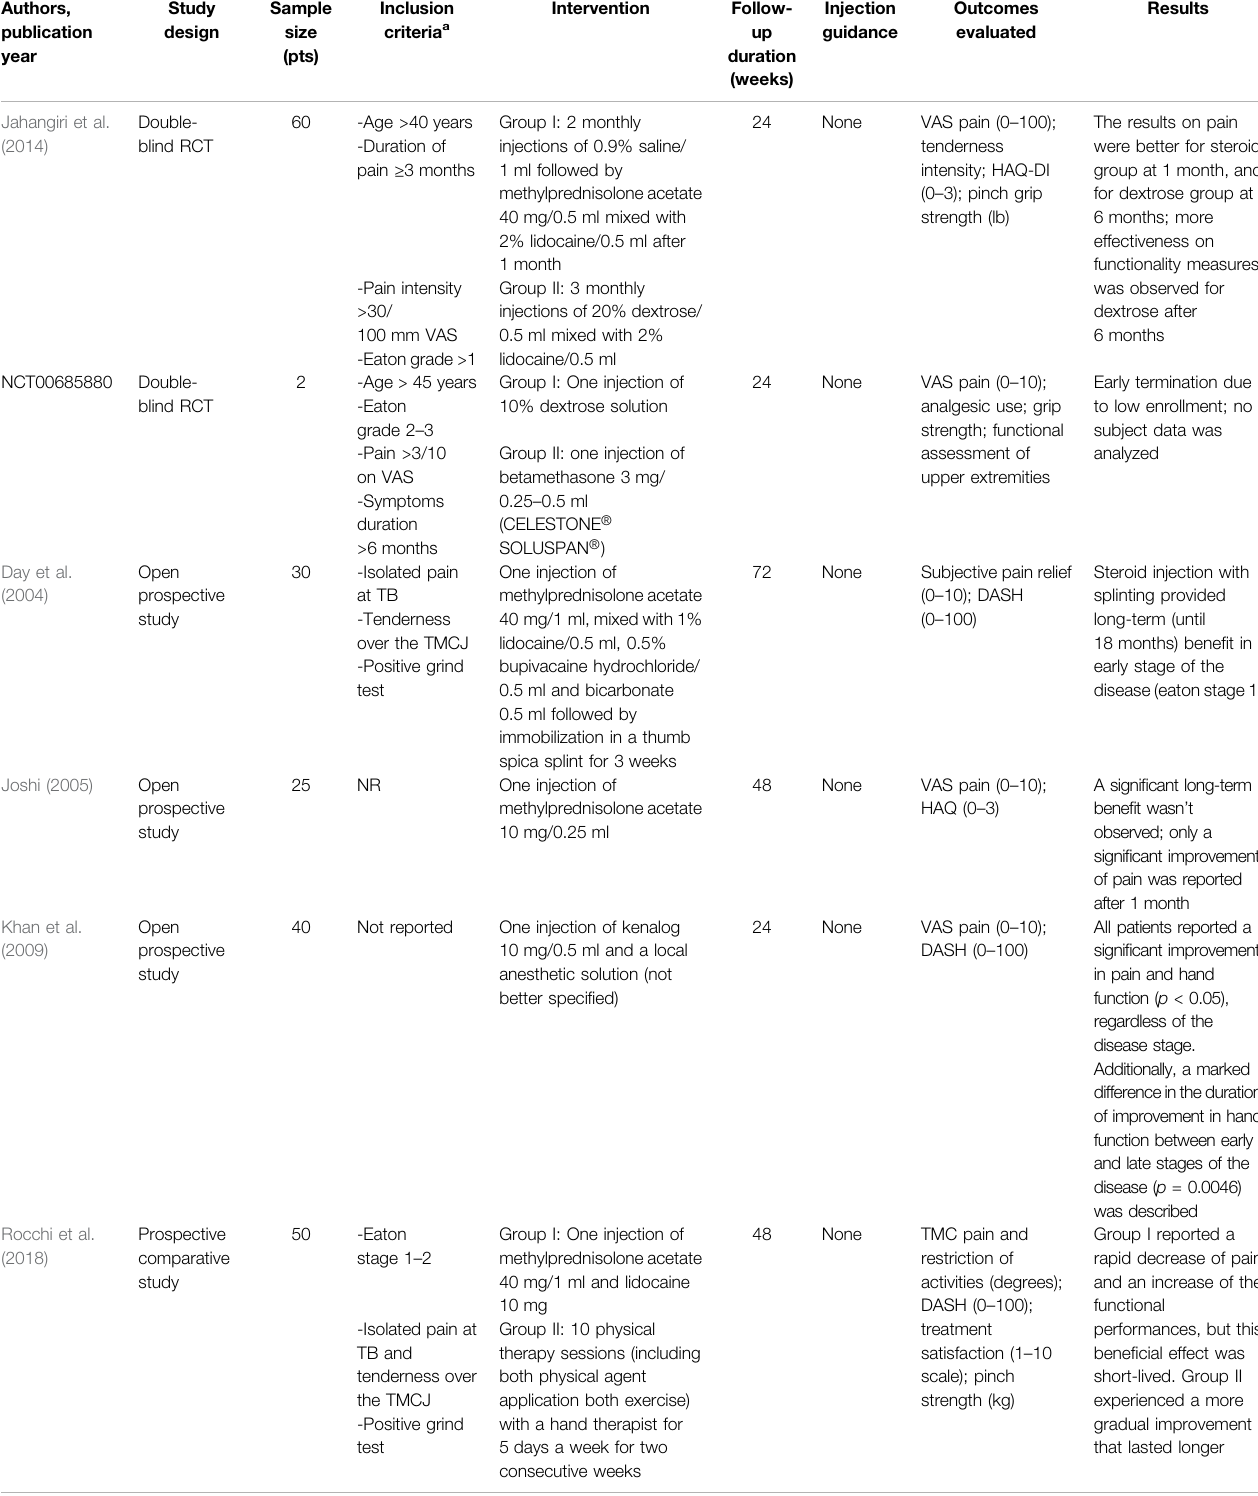
TABLE 1 | Summary of studies investigating intra-articular injections of corticosteroids for the treatment of thumb-base osteoarthritis. Authors,